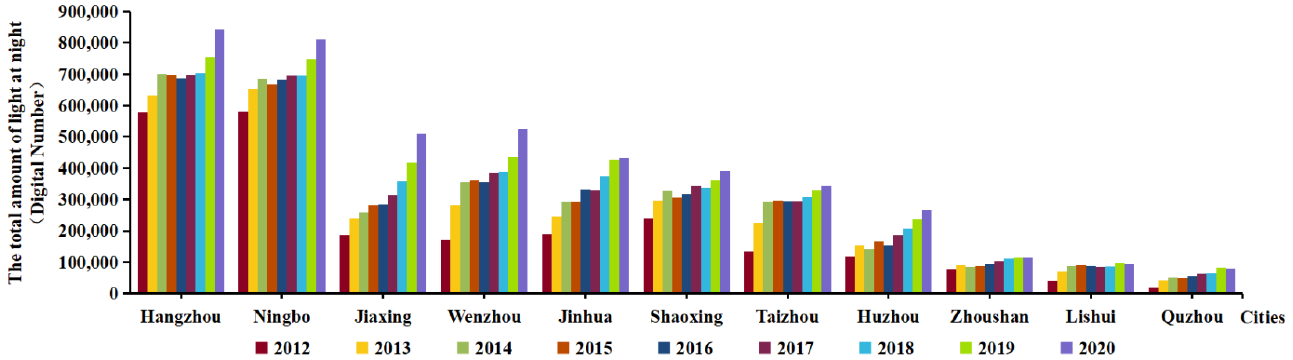
Figure 5. Total nighttime light values in the urban areas of cities in Zhejiang Province from 2012 to